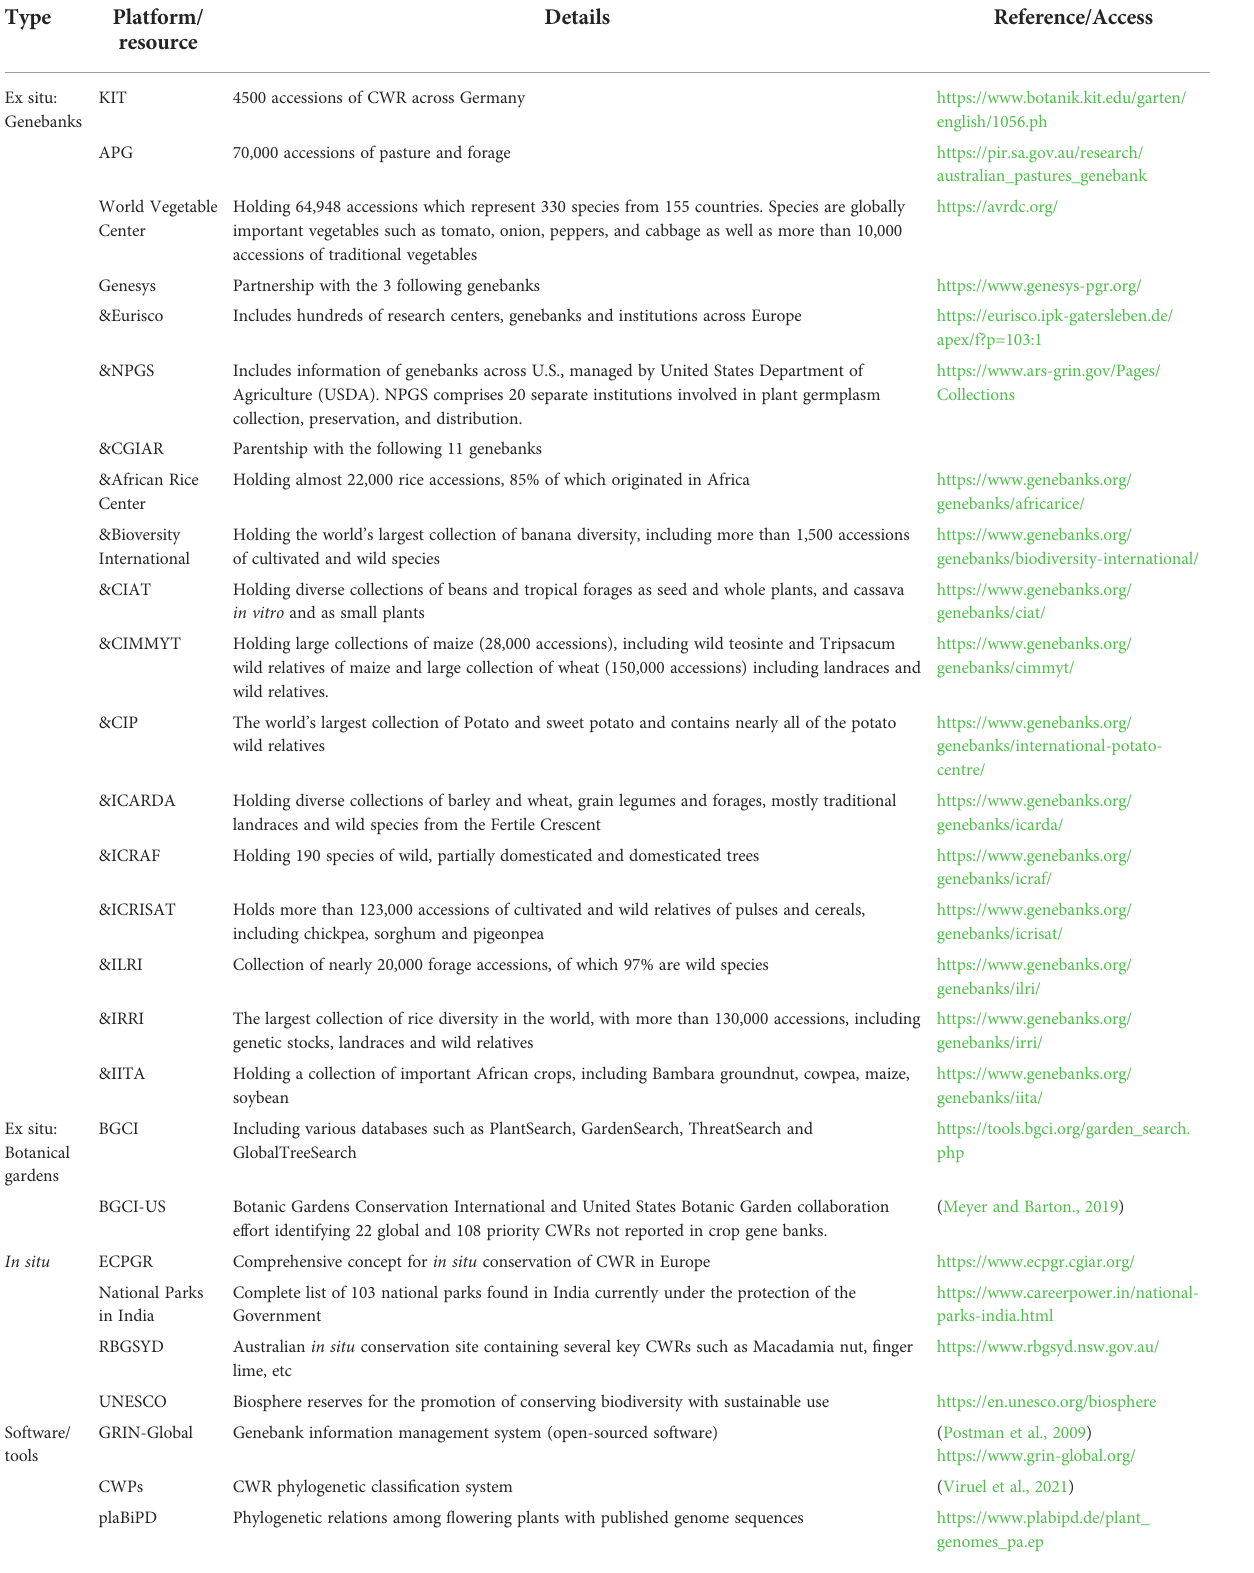
TABLE 1 A list of well-known resources and platforms that include CWR species.